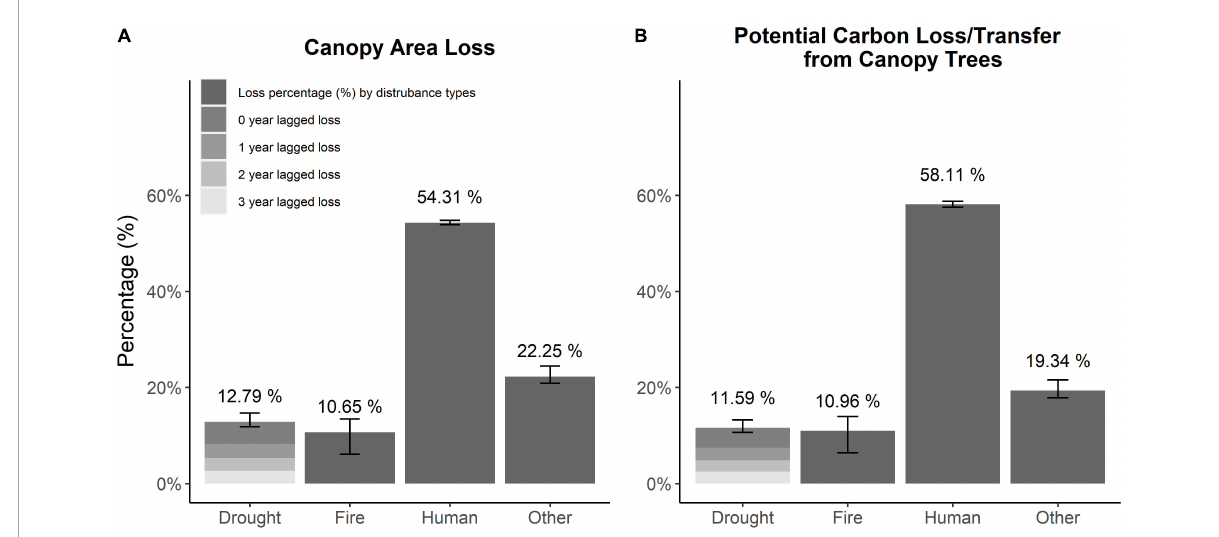
FIGURE3 Forest area and potential carbon loss/transfer from forest loss in CONUS for 2000–2014. The percentage of area (A) and potential aboveground carbon stock loss/transfer from canopy trees (B) from forest loss by disturbance types, including fire, anthropogenic (especially timber harvest), drought-associated, and others. Error bars indicate the range of lower to upper estimates for each